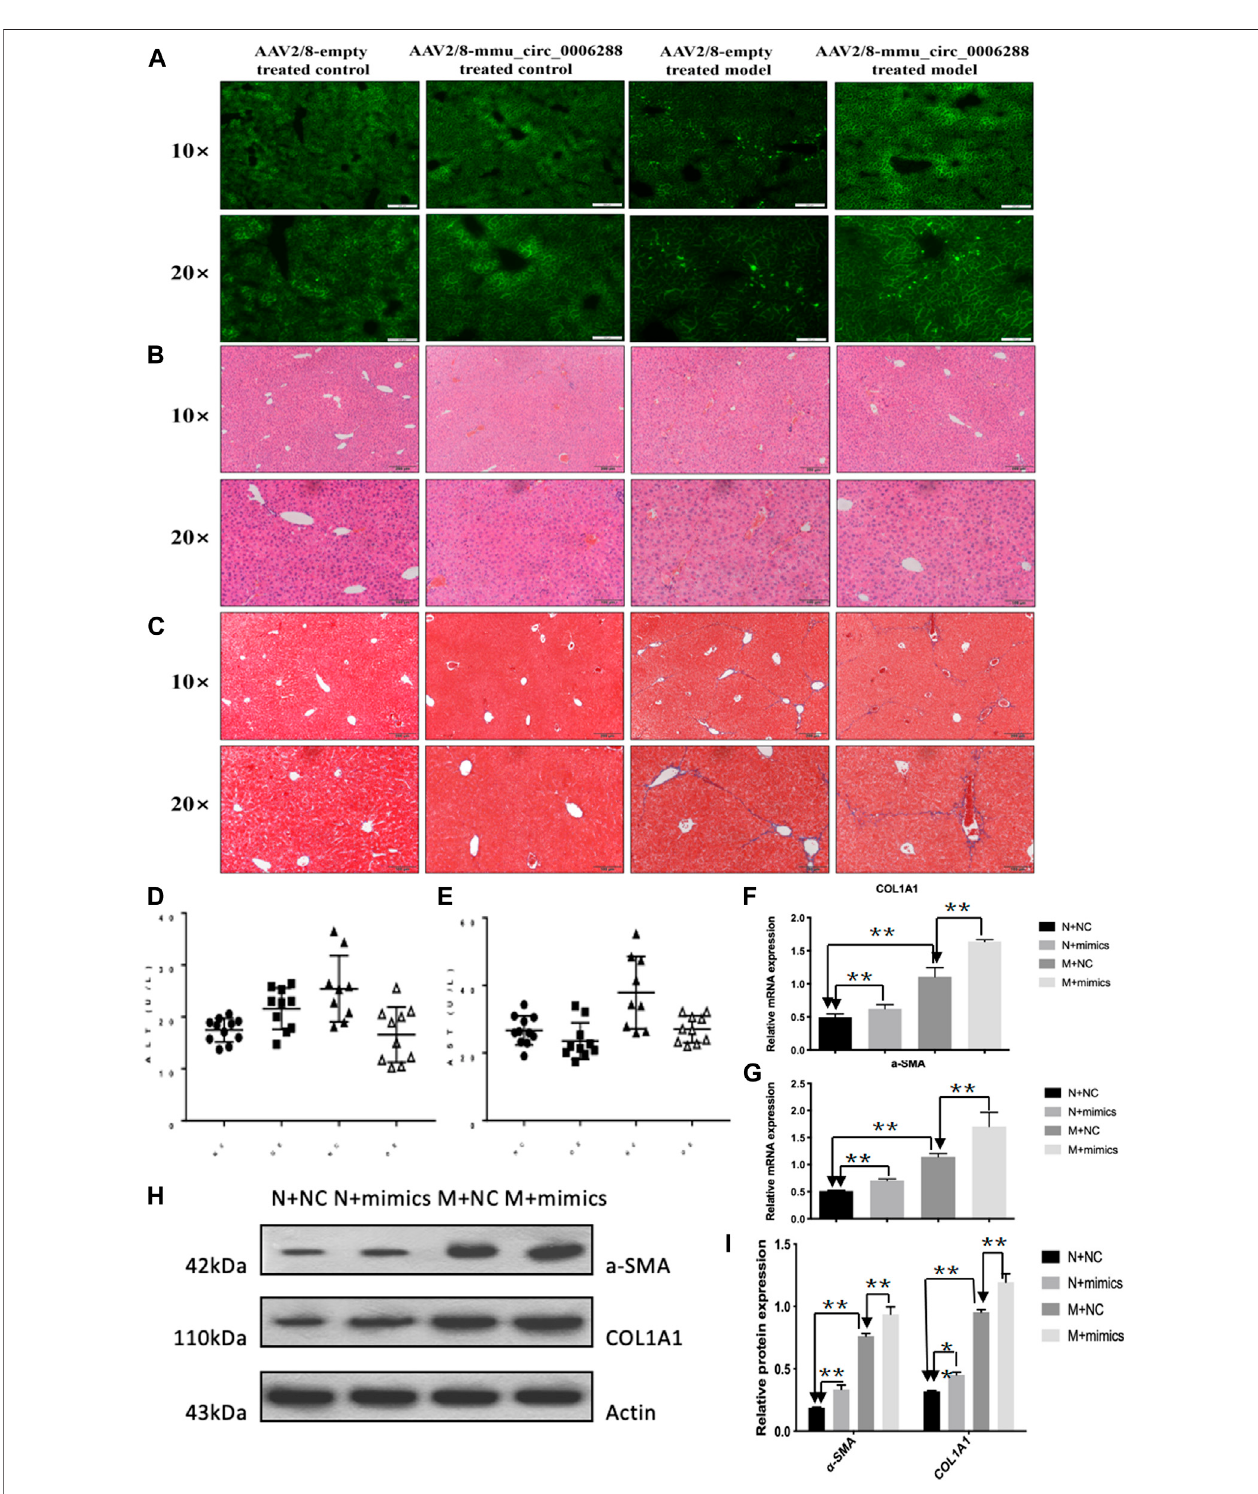
FIGURE 5 | Anti- fi brotic effects of circCREBBP in HF mice in vivo. AAV2/8-mmu_circ_0006288 was injected into the tail vein of mice (A) . Liver parenchyma and vascular architecture distortion, collagen deposition were consistently reduced in HF mice following AAV2/8-mmu-circ-0006288 administration (B,C) . The expression levelsofALTandASTinserumwerereducedinAAV2/8-mmu-circ-0006288-treatedHFmice (D,E) .The fi brosisfactor( α -SMAandCOL1A1)weredown-regulatedafter circCREBBP was overexpressed (F – I) .